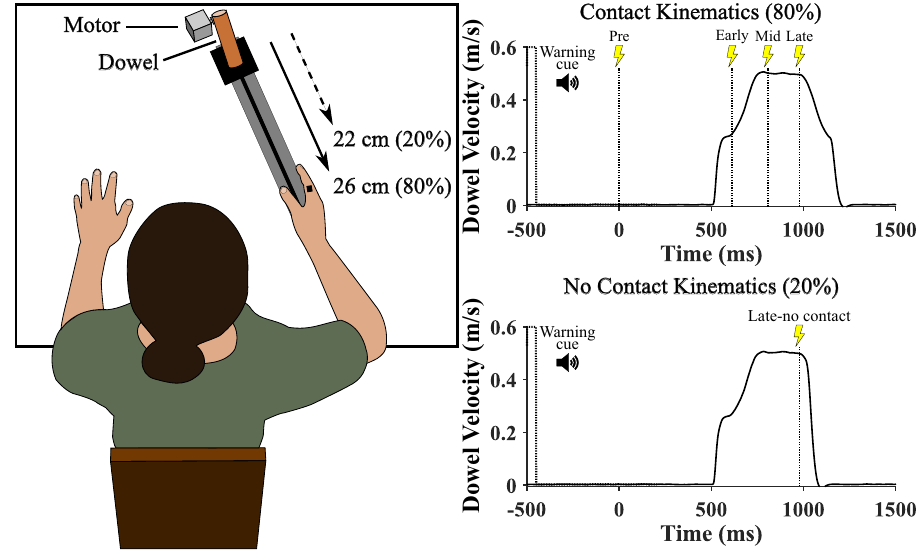
Figure 1. Left Panel: Illustration of the experimental setup. On 80% of the trials the dowel moved 26 cm (i.e., Pre, Early, Middle and Late stimulation trials) and on 20% of the trials the dowel moved 22 cm (i.e., Late-no contact stimulation trials). The stimulus location is depicted on the right index finger in black. Note that electrodes were placed on the dorsal and palmar surface of the base of the index finger. Right Panel: Dowel velocity profiles and stimulation times when the object travelled 26 cm and made contact with the individual (i.e., 80% of trials; top graph) and when the object travelled 22 cm and did not make contact with the individual (i.e., 20% of trials; bottom graph). In all conditions, a 50 ms auditory stimulus served as a warning cue and only one stimulus was presented for each trial. Note that the only difference between the contact and no